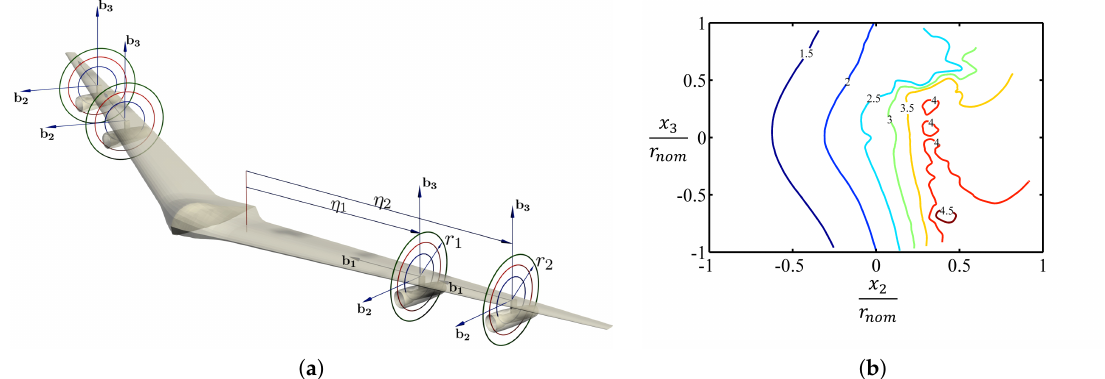
Figure 8. ( a ) Schematic view of the flying wing with four engines; ( b ) Normalized flutter speed contour for different engine locations on b 2 b 3 plane ( η 1 = 50% and η 2 = 80%) [28]. Reprinted from Mardanpour, P.; Richards, P.W.; Nabipour, O.; Hodges, D.H. Effect of multiple engine placement on aeroelastic trim and stability of flying wing aircraft. J. Fluids Struct. 2014 , 44 , 67–86, with permission from